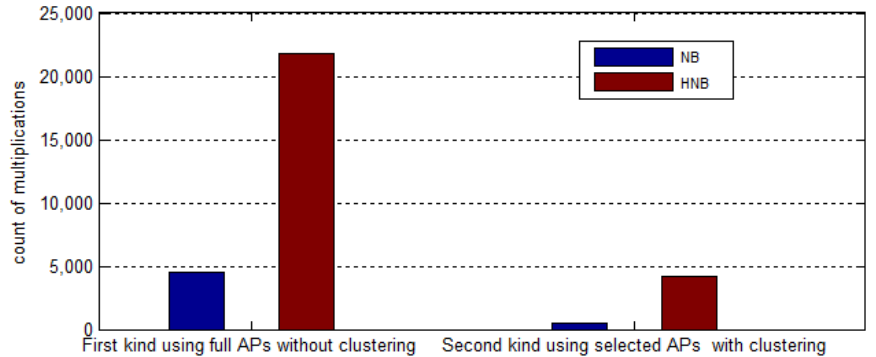
Figure 17. Computational cost comparison. HNB, hidden naive Bayes.